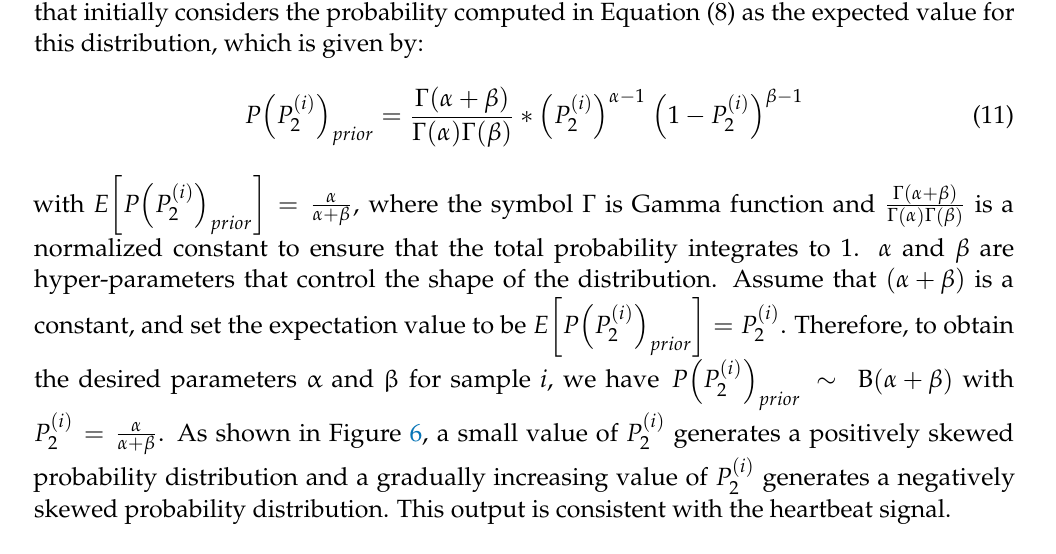
Figure 7. AMPD-BL block diagram. 2.5.5. Performance Discussion Figure 8a shows the heart rate measurements by using a static fingertip. Observe that the thin skin on the fingers, which causes less interference, leads to good detection perfor- mance with the AMPD-BL approach. However, when measuring the PPG signal on the dynamic or static wrist (the symbol “b” in Figure 7), Figure 8b,c show the performance degradation due to the much larger effect of interference in wrist PPG measurement. As shown in Figure 8d, the peak values are calibrated to better positions with the AMPD-BL (the symbol “c” in Figure 7) , but a part of the peak values are missing or calibrated to the wrong positions. To resolve the above problem, this work aims to develop a novel joint algorithm, incorporating the concepts of automatic multiscale-based peak detection and fuzzy logic control, for adjusting the signal index range of overlap and performing offset calibration.